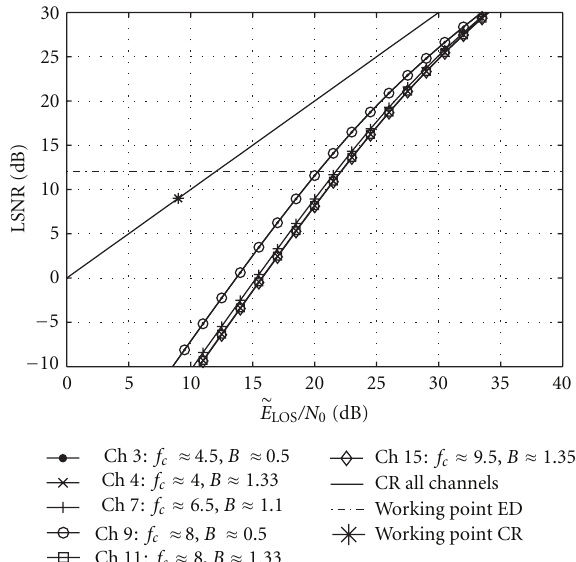
Figure 7: Relation between input SNR (cid:16) E LOS /N 0 and output SNR LSNR for the short preamble codes with a spreading L = 64 and N pr = 16 with respect to the IEEE 802.15.4a channels. The channel parameters in the legend are in GHz.